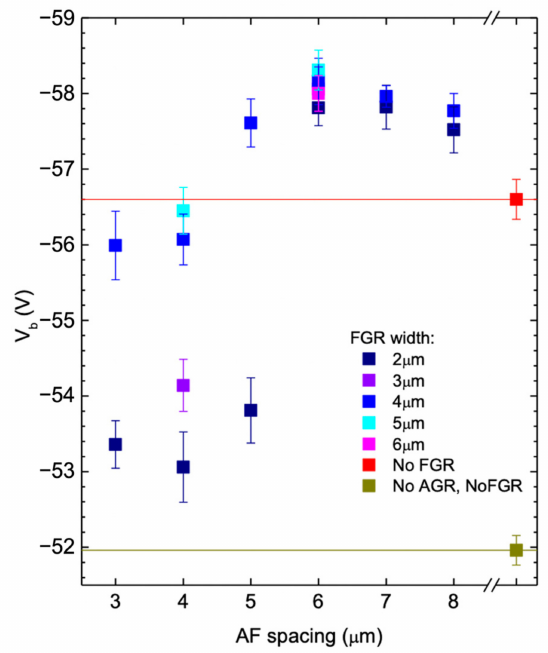
Figure 7. Breakdown voltage as a function of AF spacing for devices with different FGR widths. Red square and red line represent the devices with AGR, but without FGR. Brown square and brown line represent the devices without the guard ring